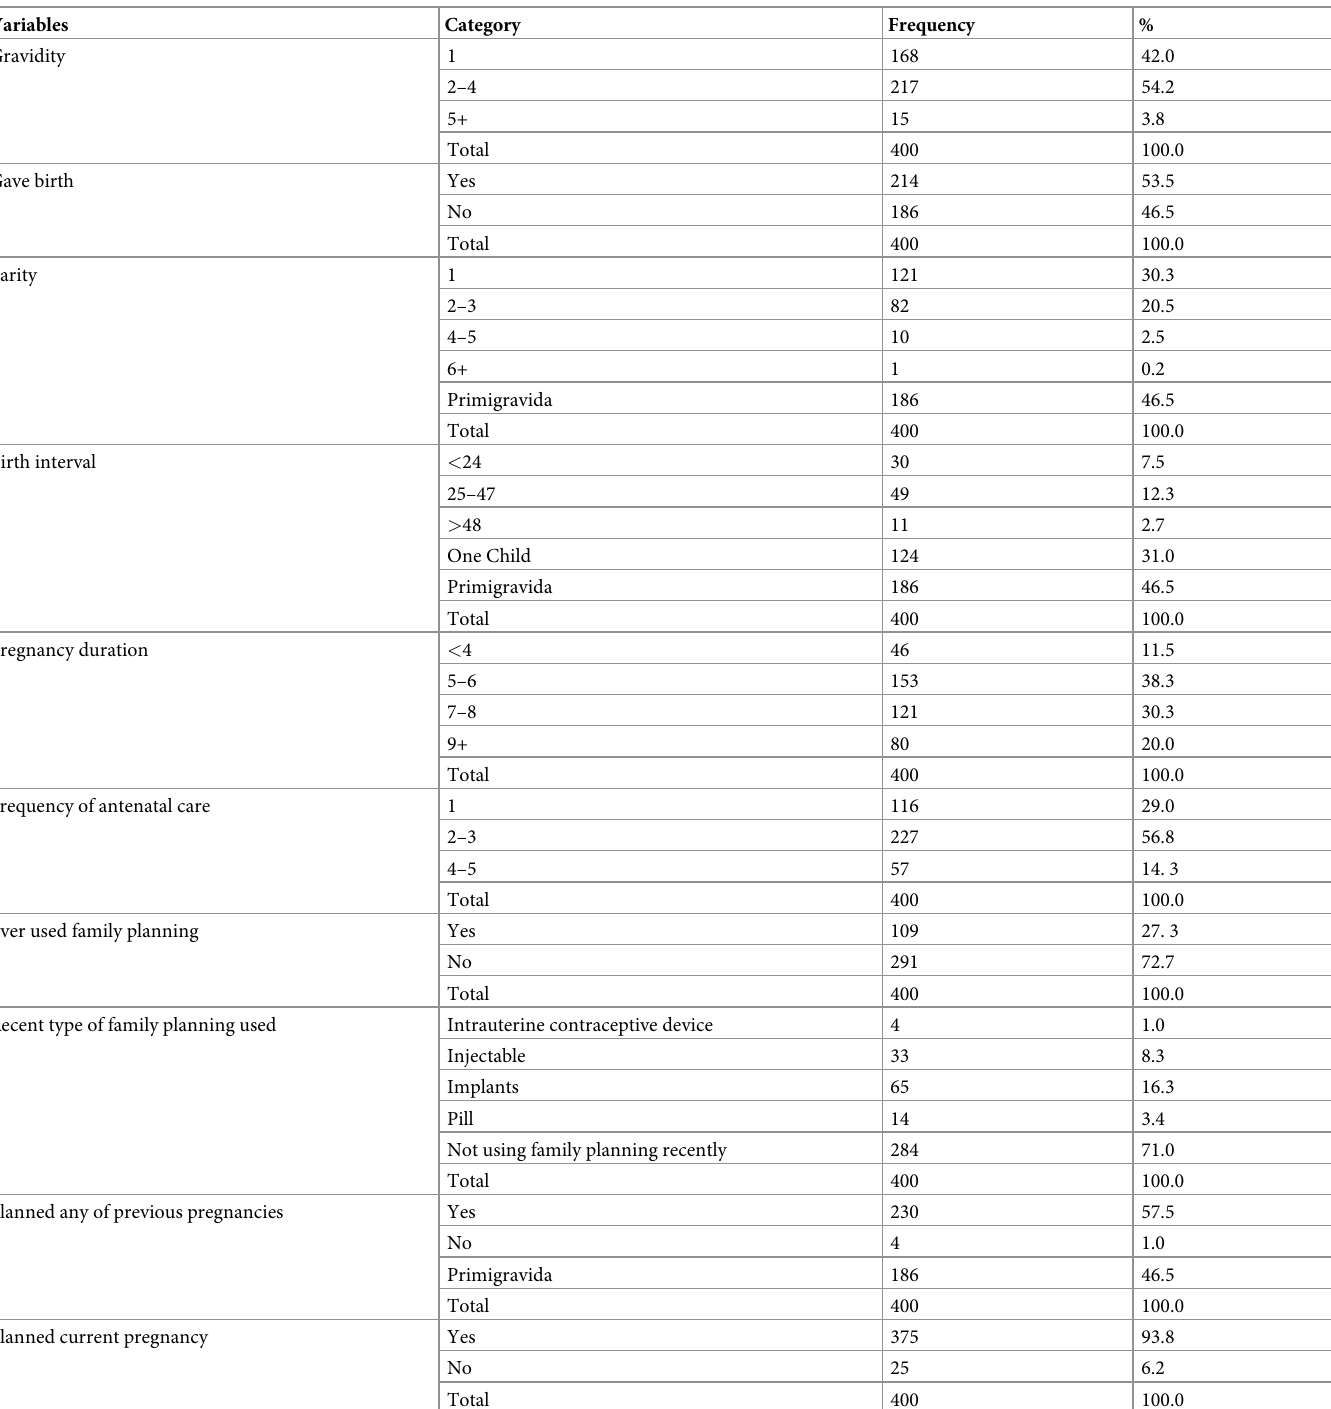
Table 2. Reproductive characteristics of women attending antenatal care clinics of public health facilities in Hossana town, Southern Ethiopia, 2020 (n = 400).